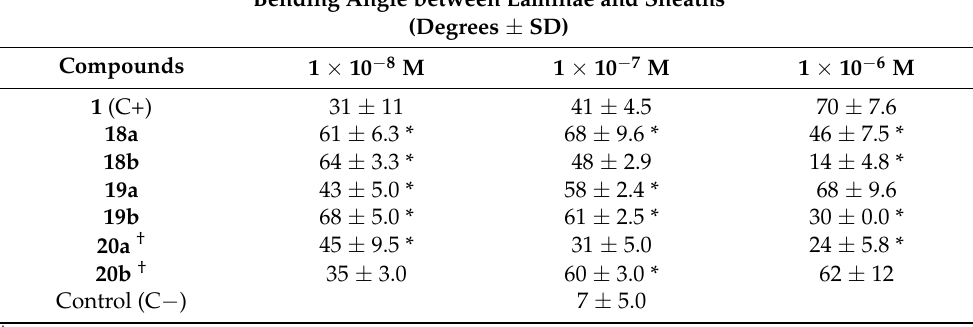
Table 4. Comparison between BRs C-3 conjugated 24-norcholane and free 24-norcholane type analogs on lamina inclination of rice seedlings. Bending Angle between Laminae and Sheaths (Degrees ±